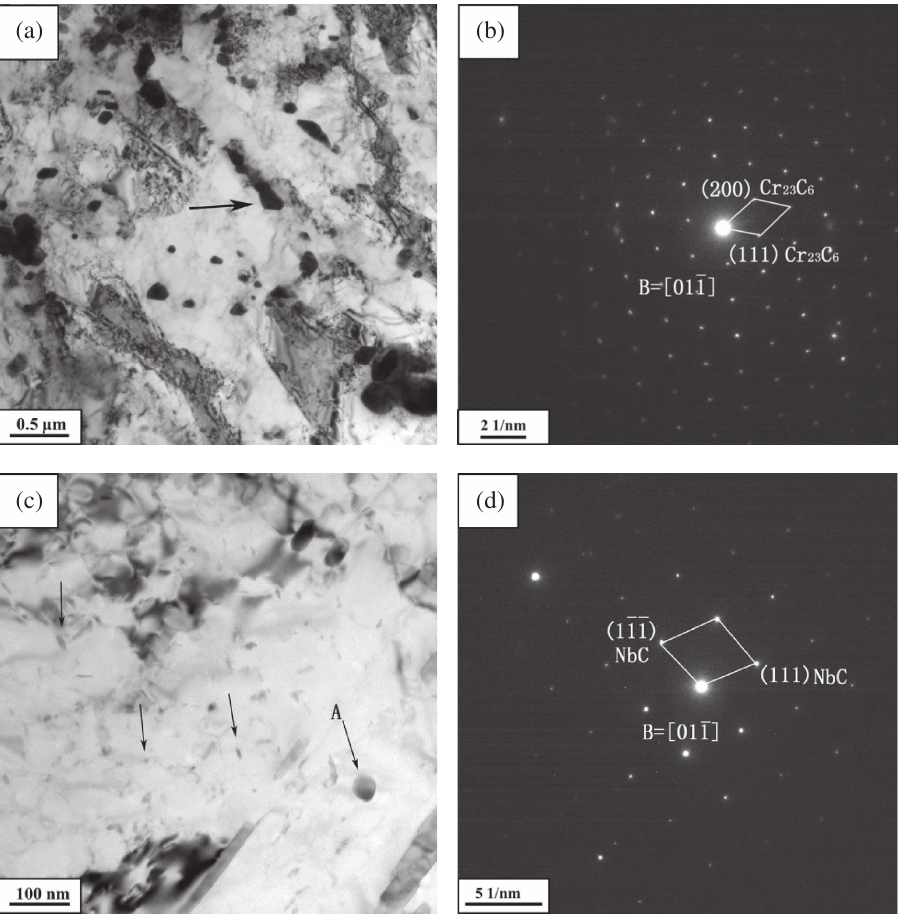
Figure 3: Morphology of carbides in ZG1Cr10MoWVNbN steel after long-term ageing at 600°C (a) Precipitation phase morphology of chain (b) The SADP corresponding to (a) (c) Precipitation phase morphology of intragranular (d) The SADP corresponding to the Figure (c) A